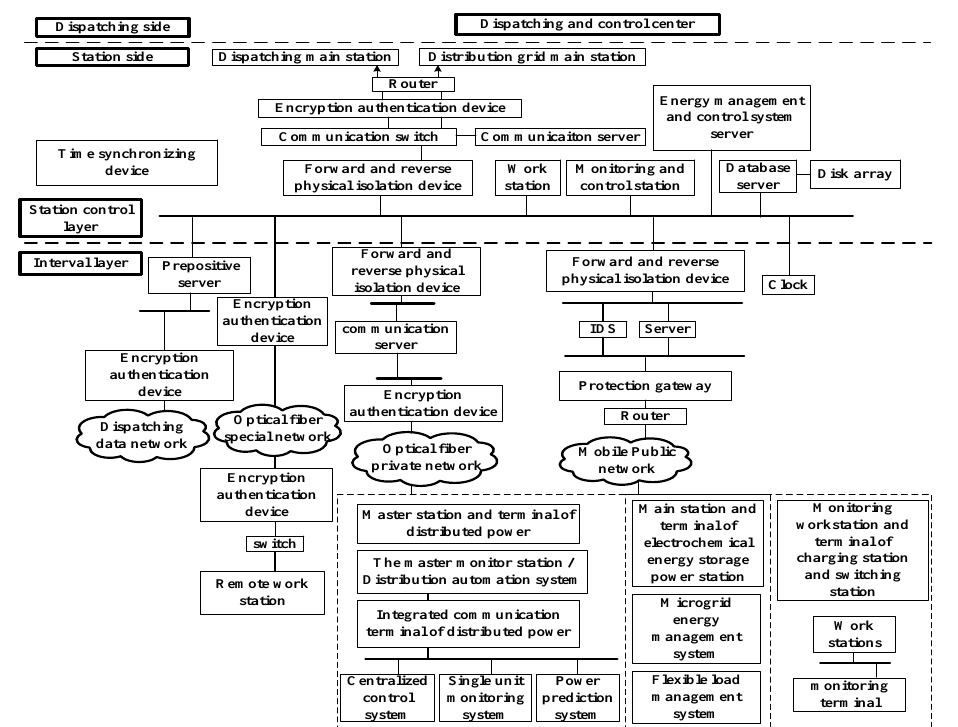
Figure 6. The structure of monitoring system.